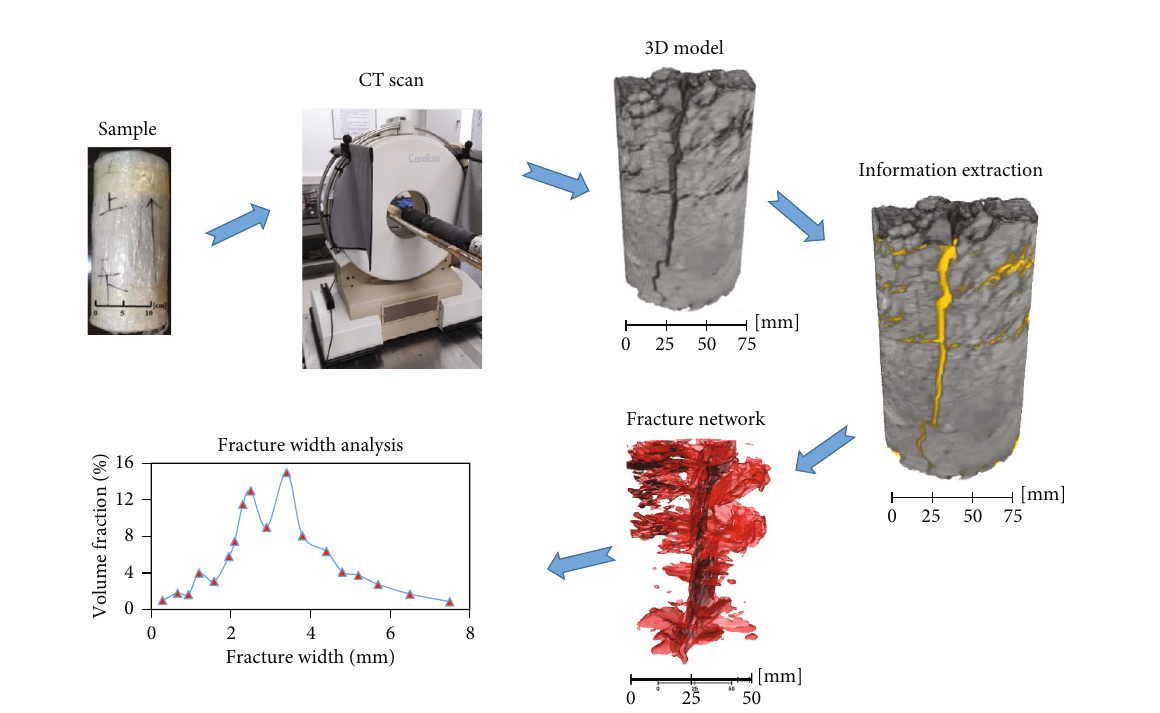
Figure 5: The process of CT scanning in clayey-silt